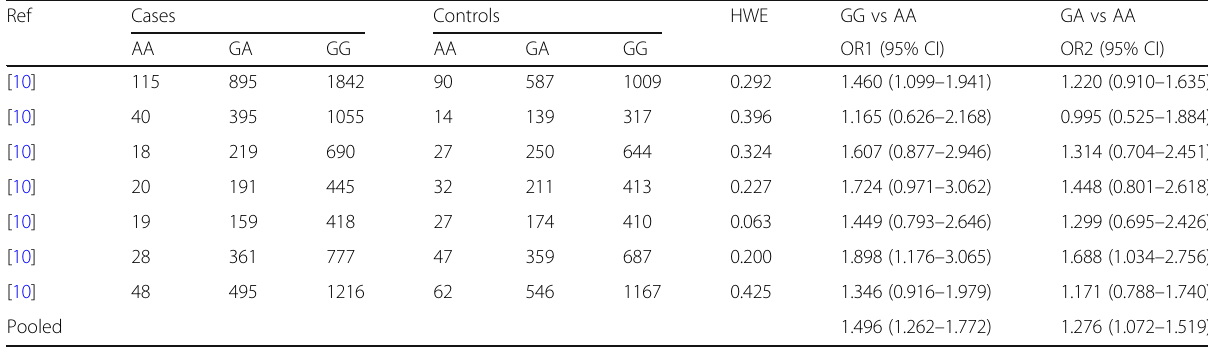
Table 3 Association between the HNF1B rs11649743 and prostate cancer (genotype distribution of case-control studies included in the meta-analysis)